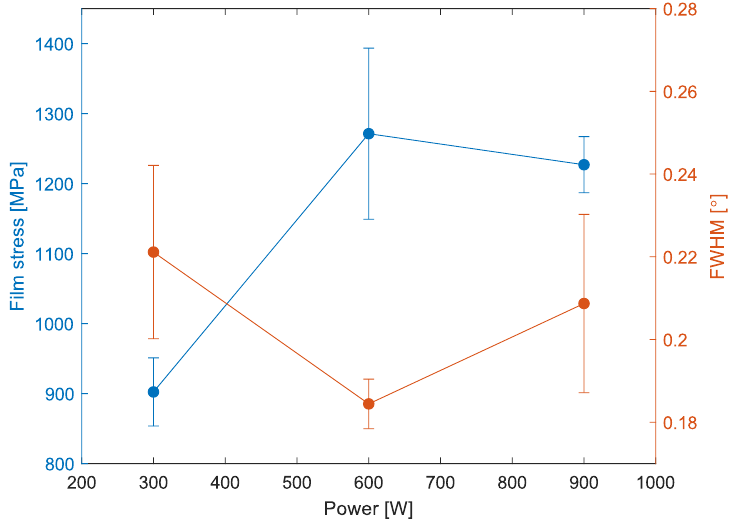
Figure 5. Film stress and FWHM of the AlN(002) peak for films grown using different powers.